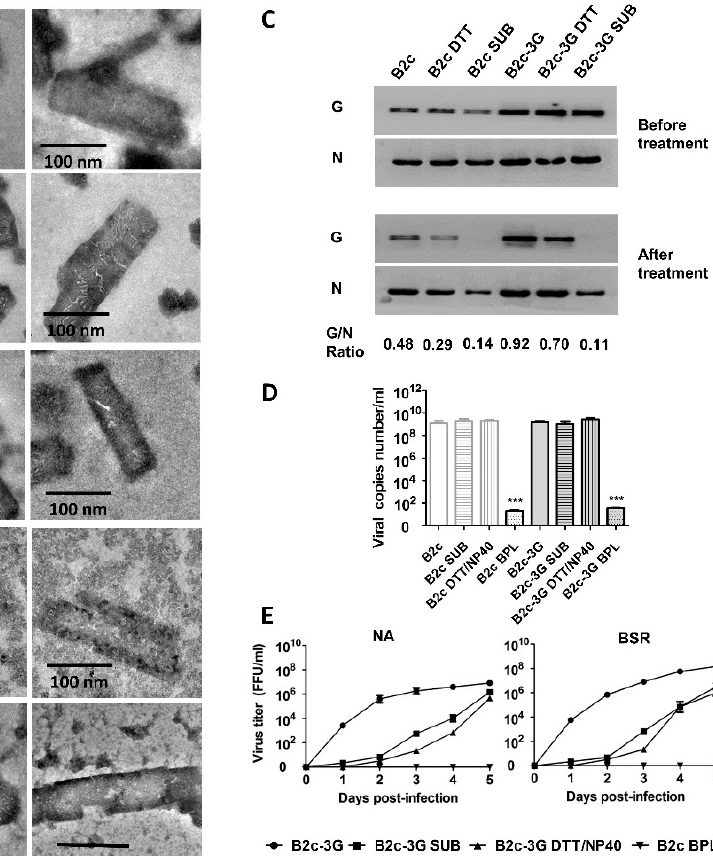
Viruses 2019 , 11 , x; doi: FOR PEER REVIEW